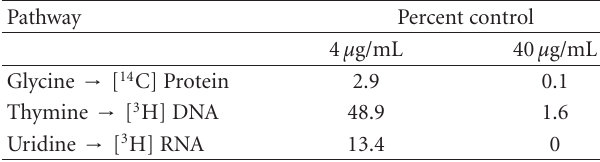
Table 5: E ff ect of berberine incubated with S180 cells in vitro a . Pathway Percent control 4 μ g/mL 40 μ g/mL Glycine → [ 14 C] Protein 2.9 0.1 Thymine → [ 3 H] DNA 48.9 1.6 Uridine → [ 3 H] RNA 13.4 0 a Data obtained from W. A. Creasey